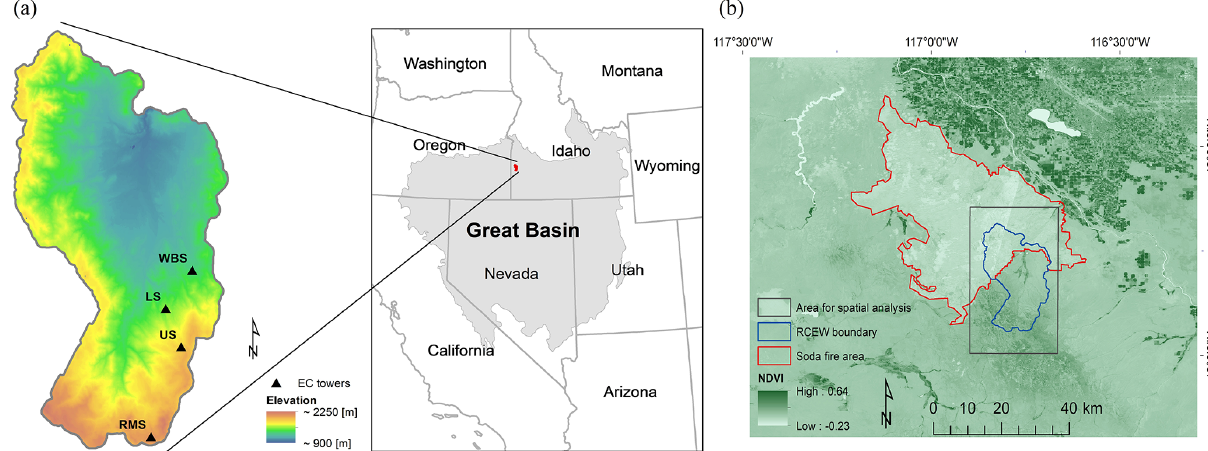
Figure 1. (a) Location of the four EC flux tower sites within the Reynolds Creek Experimental Watershed (RCEW) study area. The inset map shows the location of the RCEW within the northern Great Basin (LCC, 2015). The Great Basin area is shown in grey shading. (b) Map showing area affected by the Soda Fire, 2015 (red boundary), boundary of the RCEW (blue boundary), and rectangle covering the RCEW (black polygon) used to run the regional EDv2.2 simulations. Normalized difference vegetation index (NDVI; Landsat image, August 2015) map in the background shows the disturbance from fire in the Soda Fire area. Table 1. Description of EC sites used in the point-based analysis. Site AmeriFlux ID Location [lat, long] Elevation